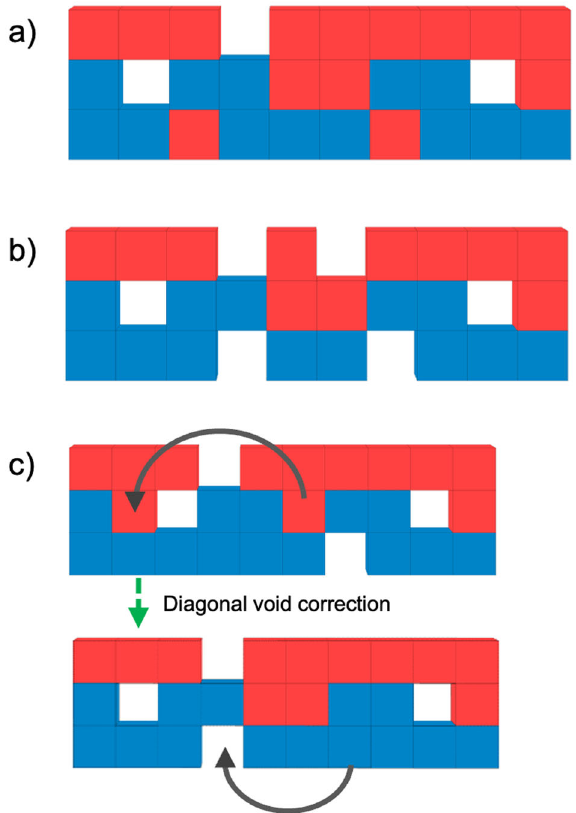
Fig. 4 The mutations are applied to the genome created from random crossover in Fig. 3. ( a ) two active material voxels replace a passive material and a void element, ( b ) two void elements replace an active and a passive material voxel, ( c ) a sequence shifting is applied and upon encountering a restriction, a different shift point is